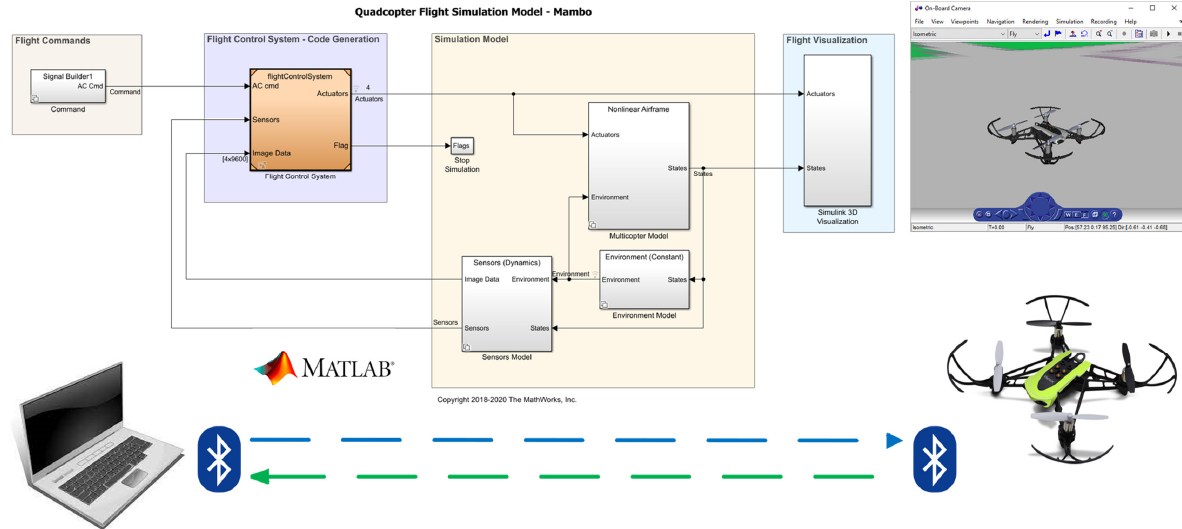
Figure 5. Simulation and experimental setup for the Parrot Mambo Minidrone Table 2. PID gains parameter.